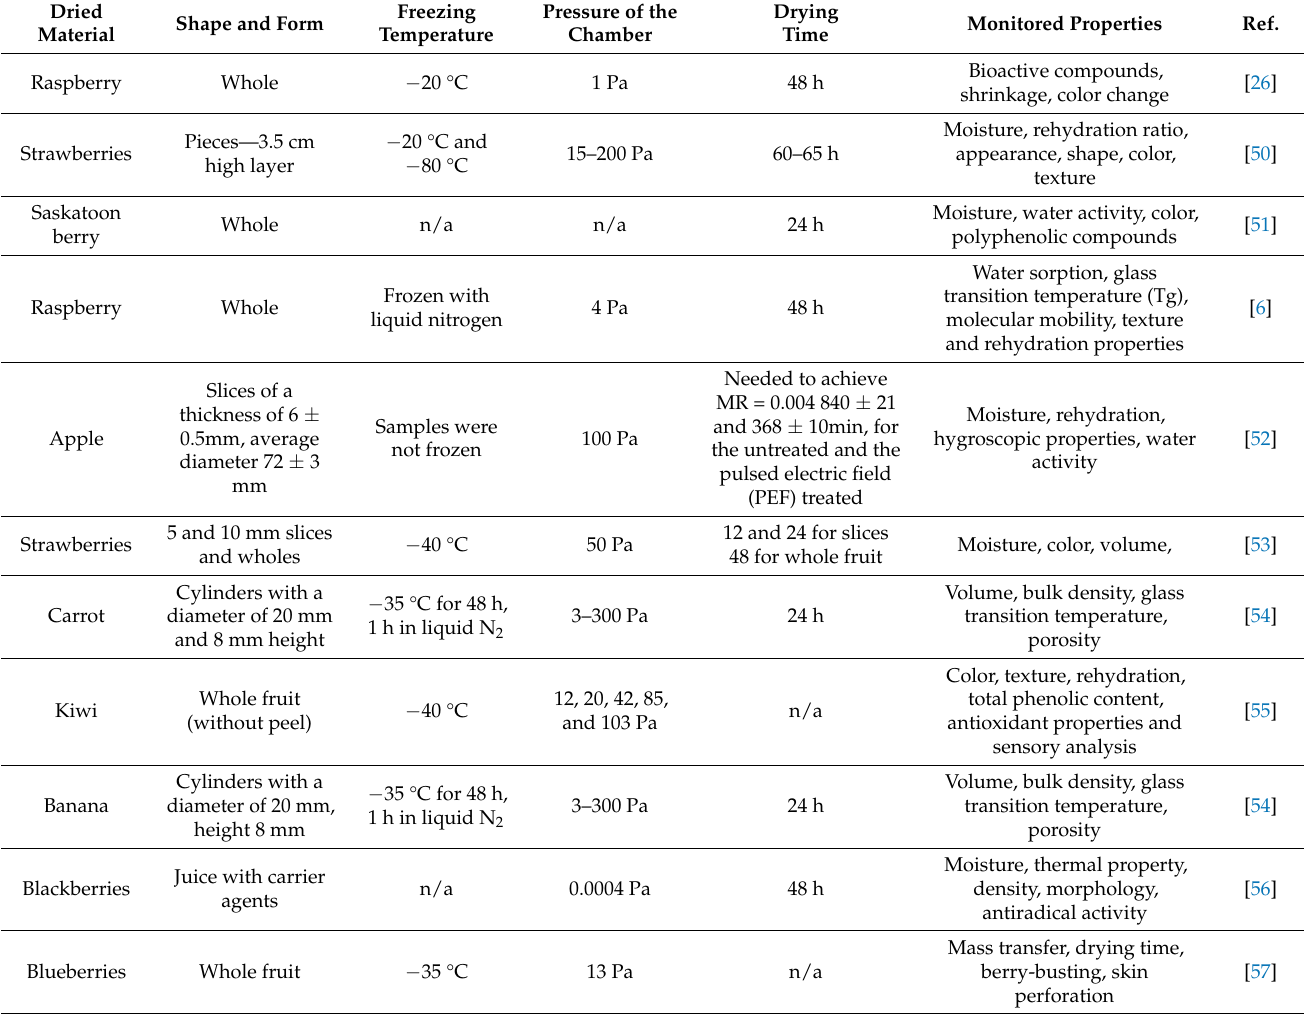
Table 1. Examples of freeze-dried fruits with various operational